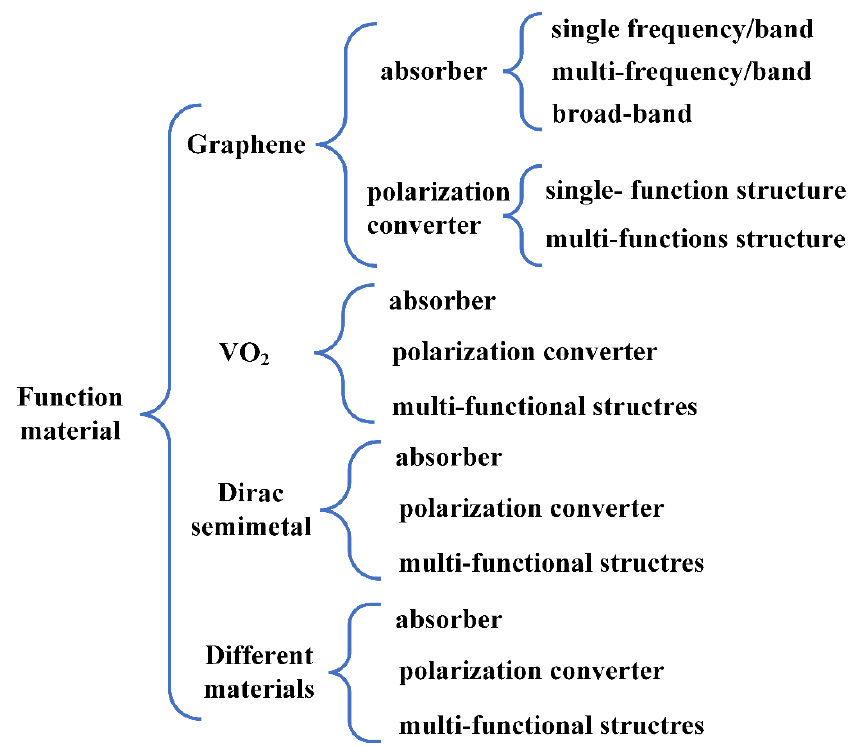
Figure 1. Organization structure of this review.